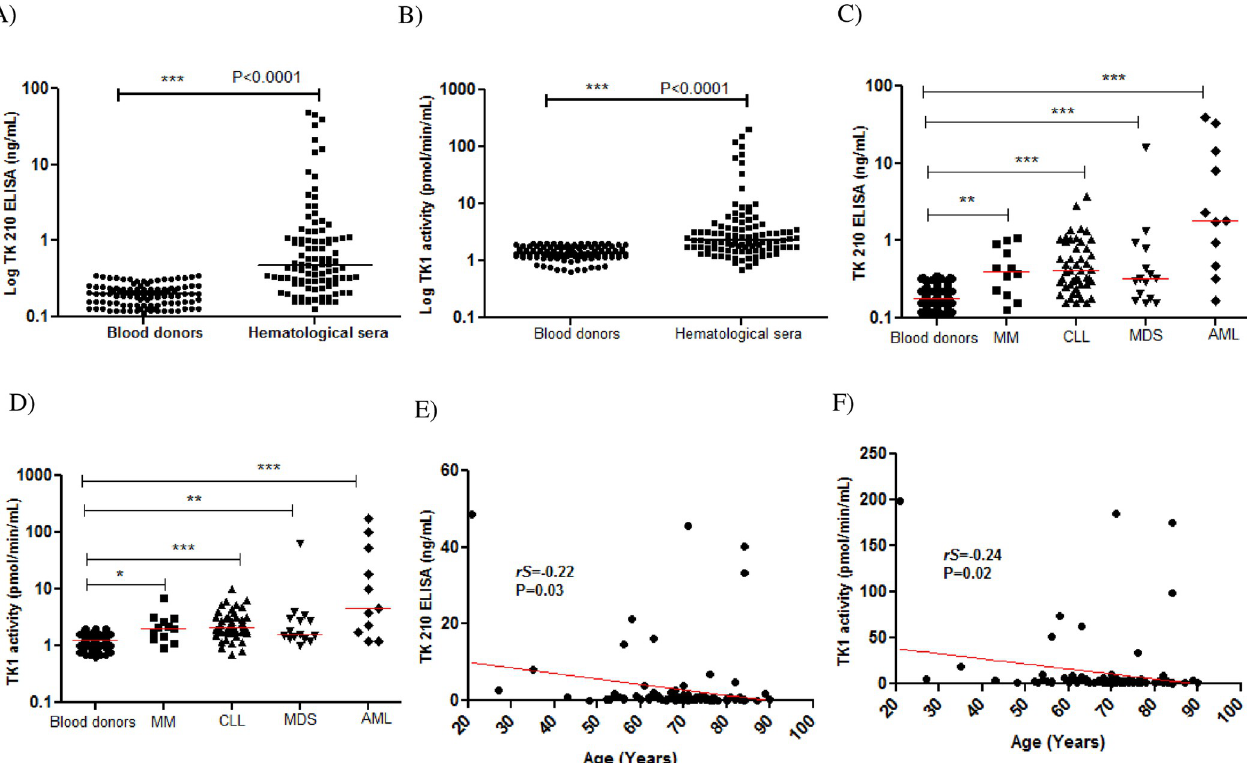
Fig 6. TK1 protein and TK1 activity levels in sera from patients with hematological malignancies. (A) TK1 protein distributions in sera from blood donors ( ● ) and patients with hematological malignancies ( ■ ). (B) TK1 activity levels in sera from blood donors ( ● ) and patients with hematological malignancies ( ■ ). (C) Comparison of TK1 protein levels in sera from blood donors ( ● ), MM ( ■ ), CLL ( ▲ ), MDS ( ▼ ). and AML ( ■ ). (D) Comparison of TK1 activities in sera from blood donors ( ● ) MM ( ■ ), CLL ( ▲ ), MDS ( ▼ ). and AML ( ■ ). The error bars denote median. (E) Correlation between TK 210 ELISA (ng/mL) and age (years) in HM patients. (F) Correlation between TK1 activity and age (years) in HM